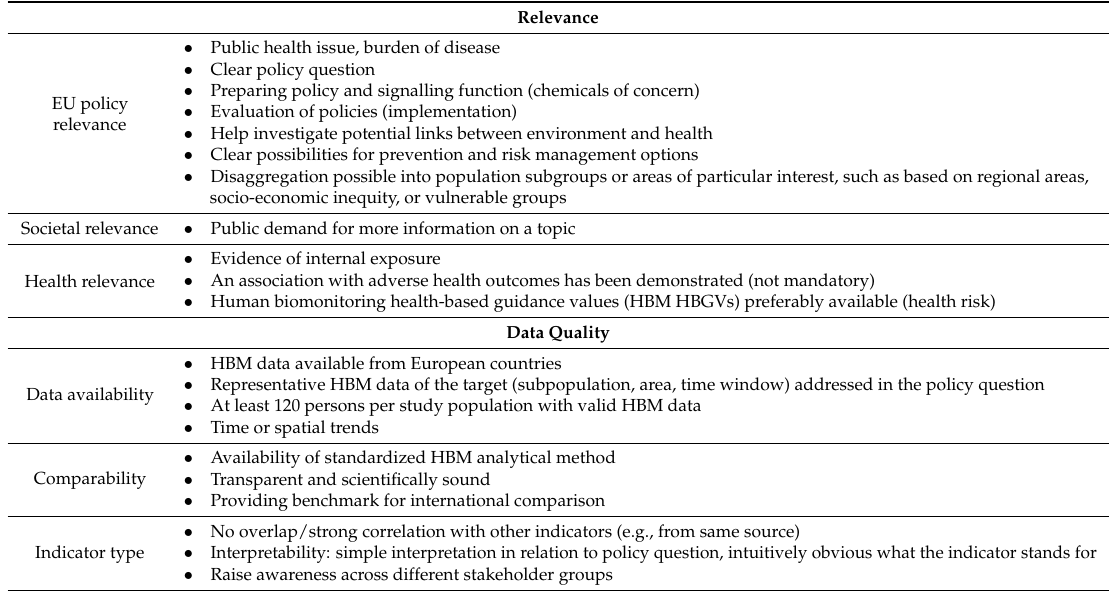
Table 1. List of criteria for the selection of chemicals for which human biomonitoring (HBM) indicators can be